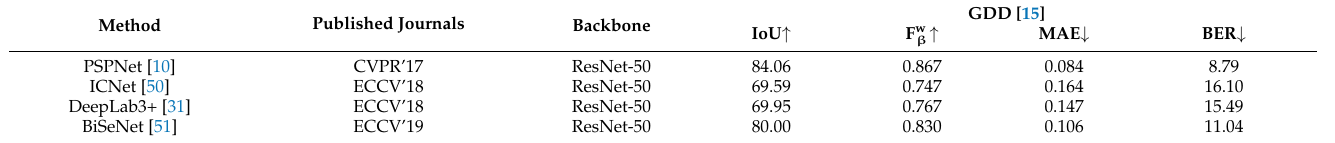
Table 1. Quantitative comparison of our designed network TGSNet with classical and non-open- source algorithms on the GDD dataset. Red indicates the best results, and blue indicates the second- best